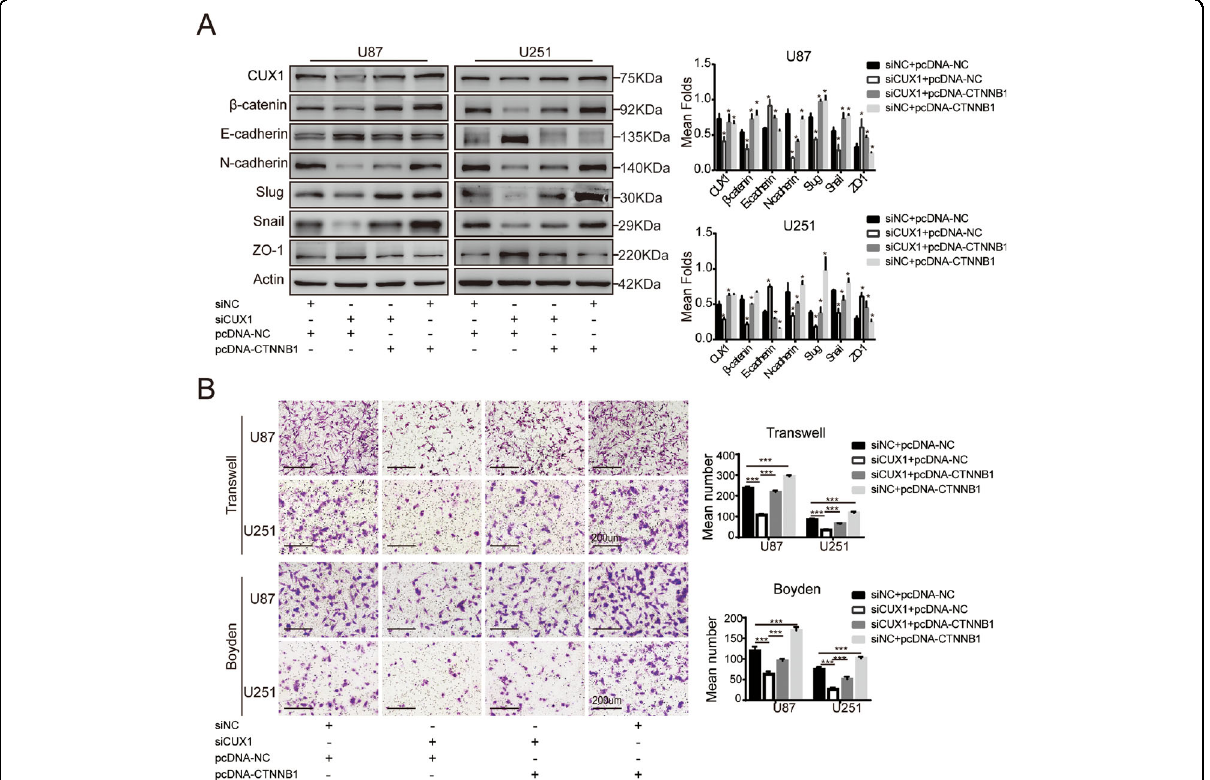
Fig. 5 β -catenin mediated the effect of CUX1 on EMT process, migration, and invasion. a WB assay showed that β -catenin overexpression could reverse the decreased EMT process induced by siCUX1 in U87 and U251 cells (* P < 0.05). b Transwell and Boyden assays indicated that β -catenin overexpression could reverse the decreased migratory and invasive capacity induced by siCUX1 in U87 and U251 cells (*** P <